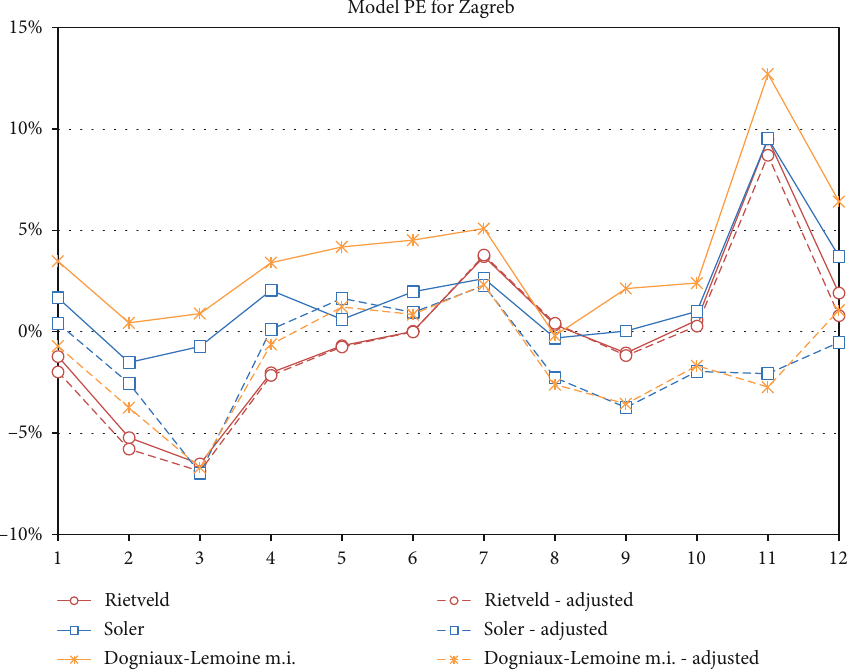
Figure 6: Comparison of percentage error of original and adjusted models for